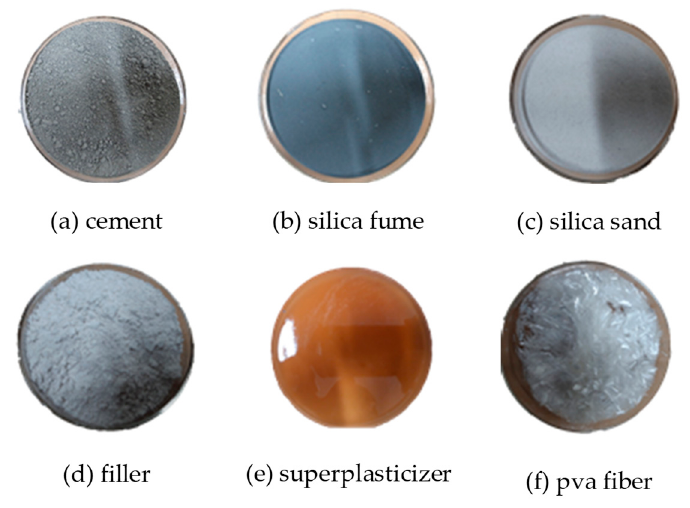
Figure 3. Detailed image of materials.